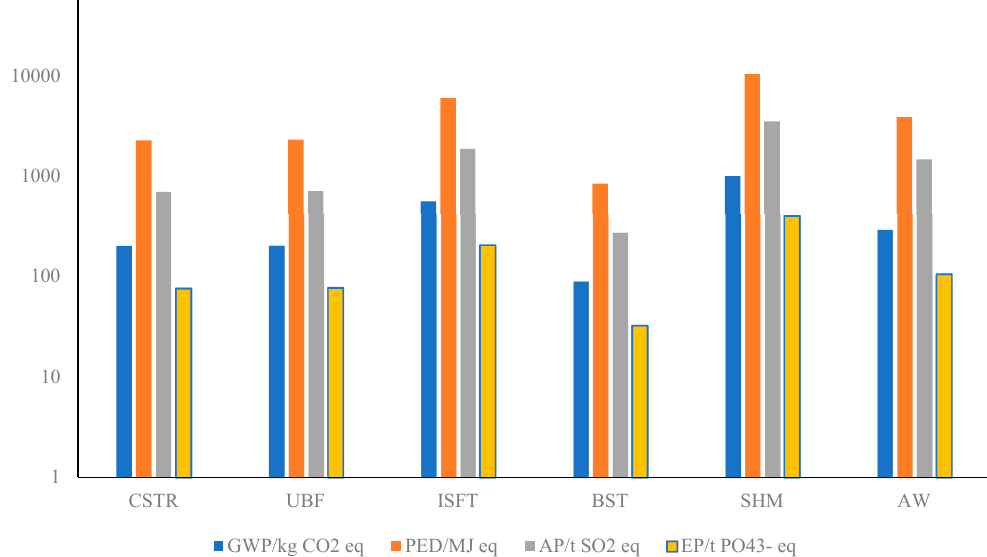
Figure 3. GWP, PED, AP and EP equivalents of the six system modules. Note: GWP—global warming potential, PED—primary energy depletion, AP—acidification potential, EP—eutrophication potential.